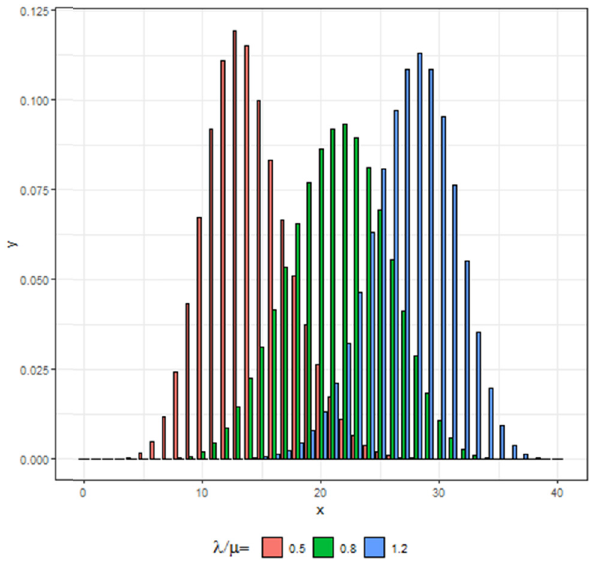
Figure 5: Probability distribution of individual states in steady state, for λ / μ = 0.5, λ / μ = 0.8, and λ / μ =